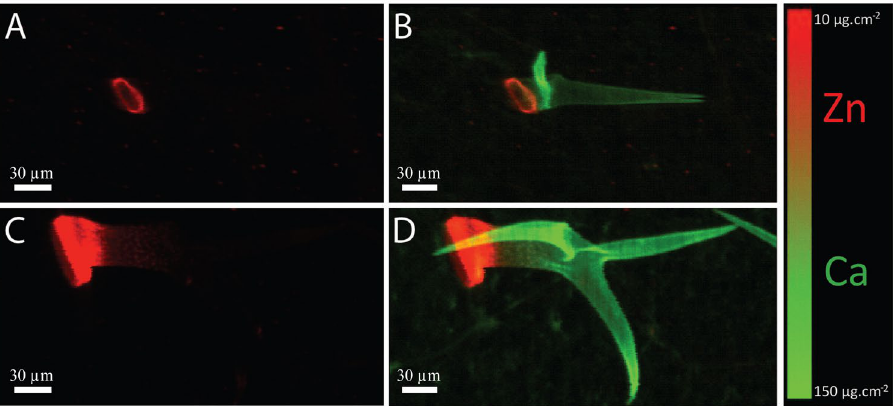
Figure 3. High-resolution elemental maps of individual fresh hydrated trichomes. Maps show Zn (in red) in trichomes of Col-0 ( A ) and OsZIP7-OE ( C ), and Zn and Ca (in green) localization overlay of Col-0 ( B ) and OsZIP7-OE ( D ).